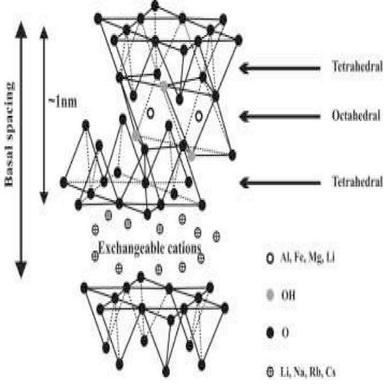
Model structure of MMT.